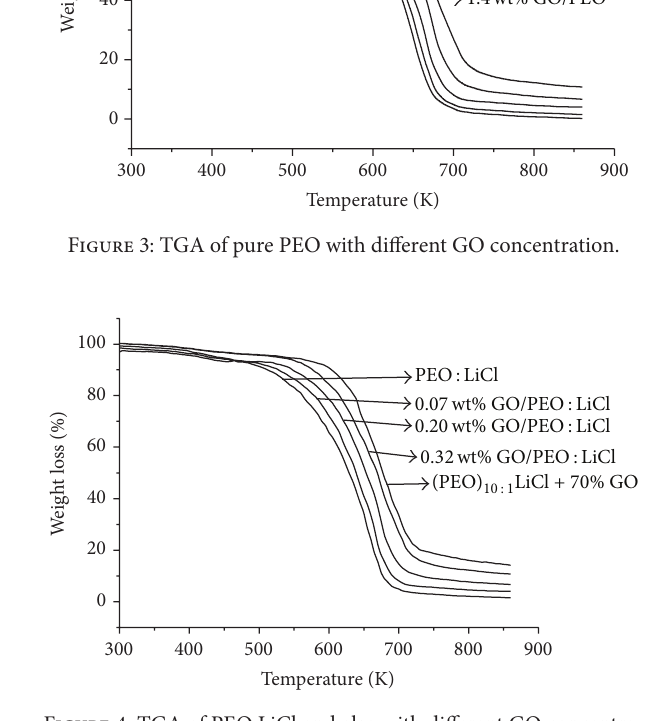
Figure 4: TGA of PEO:LiCl and also with different GO concentra-